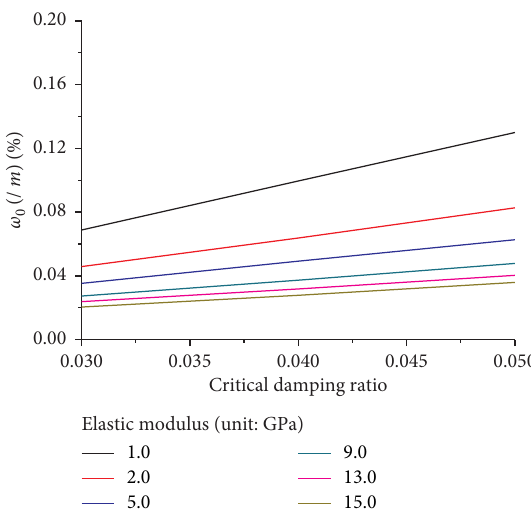
Figure 6: Empirical relationships of ω and critical damping ratio under different elastic modulus. 0 Table 2: Mechanical properties of the materials used in the numerical example. Material Density (kg/m 3 )